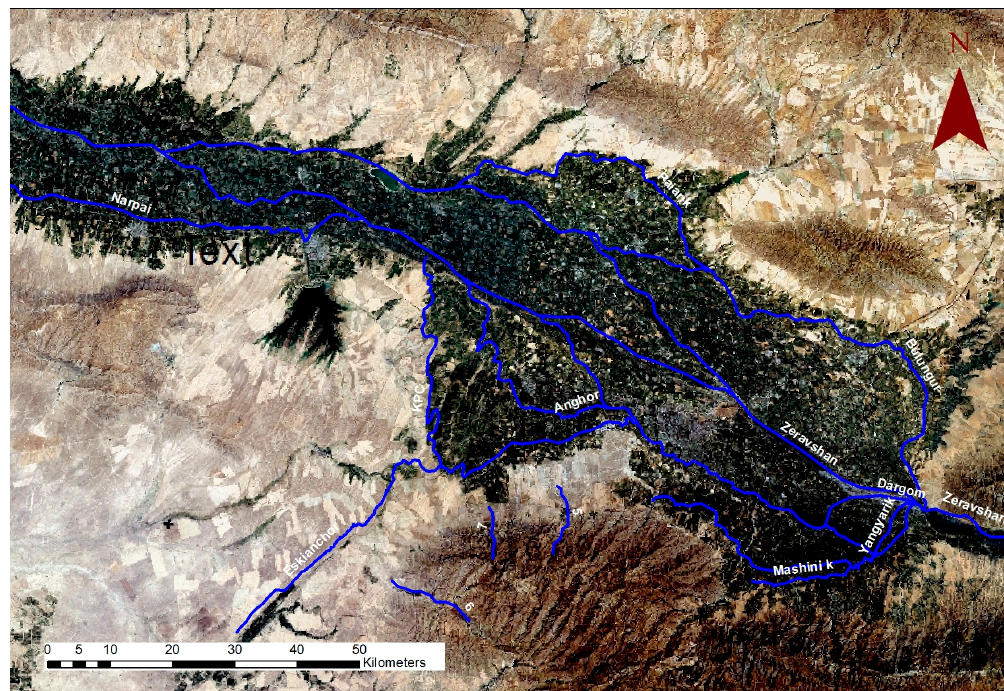
Figure 1. GIS Elaboration of a satellite image (Landsat 5) of the Middle Zeravshan waterscape representing the canals network (source: authors).